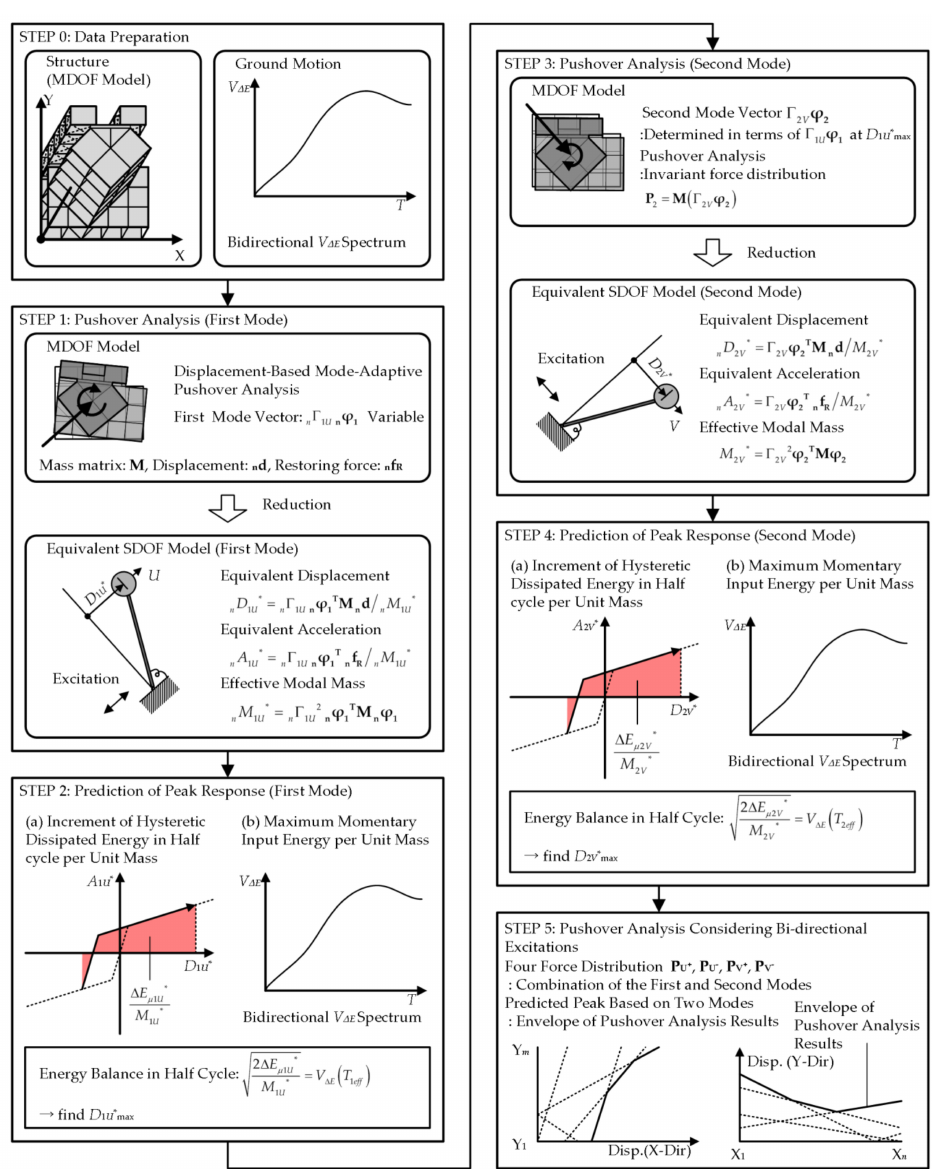
Figure 1. Flow of updated mode-adaptive bi-directional pushover analysis